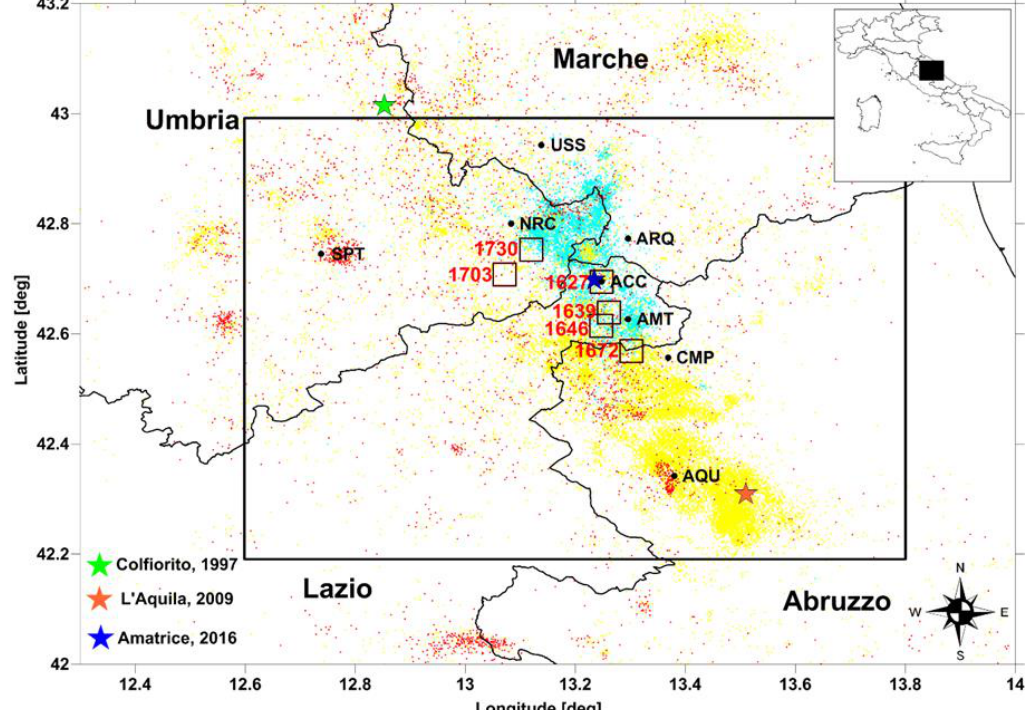
Figure 1. Shallow seismicity map (M  1.4) for the Central Apennines region (April 16, 2005-September w 16, 2016). Historical seismicity (CPTI15 release 1.5, Rovida et al. 2016) is highlighted by black squares (the numbers are referred to the years of occurrence). The main shocks of the 1997 Colfiorito, 2009 L’Aquila and the recent 2016 Amatrice are shown as green, red and blue stars, respectively. The seismicity of three ana- lyzed time periods is reported in different colors: the first one in red, the second one in yellow and the last in blue (see for details Table 1). The black box highlights the area under study (i.e., 12.6°E–13.8°E, 42.2°N–43.0°N). Black dots are the main towns: AQU=L'Aquila, CMP=Campotosto, AMT=Amatrice, ACC=Accumoli, ARQ=Arquata del Tronto, NRC= Norcia,